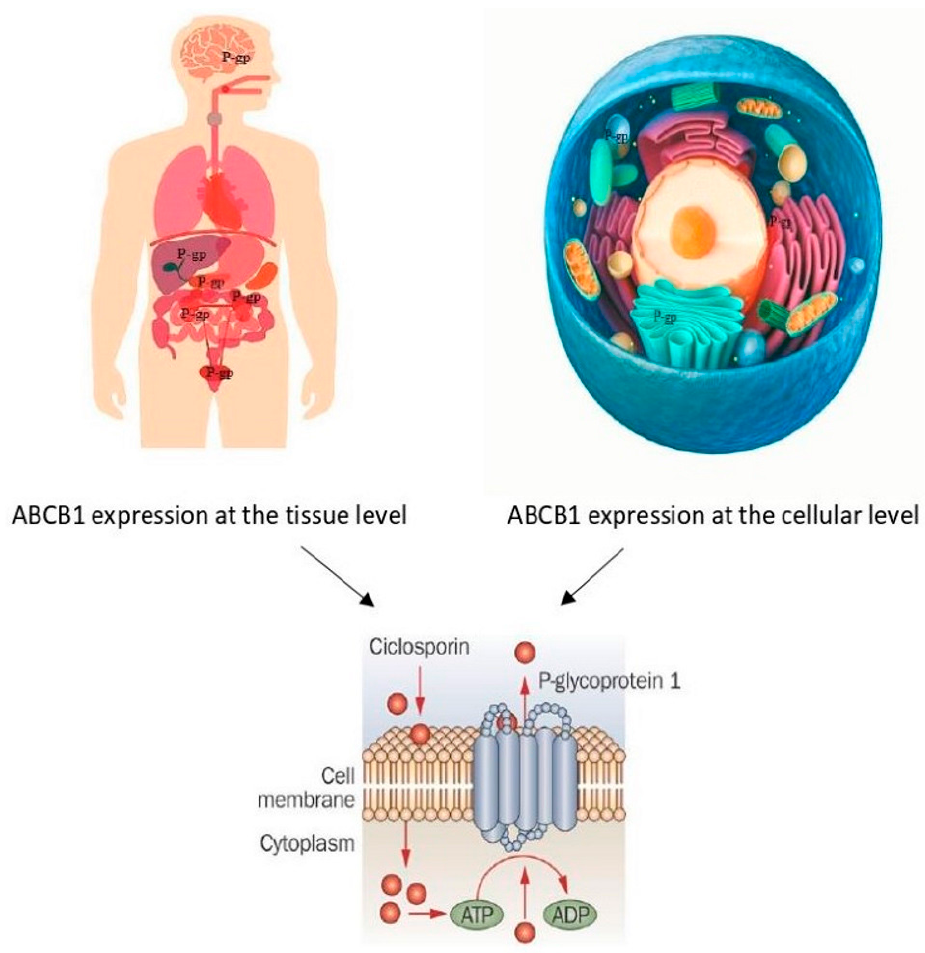
Figure 1. PGP (P-gp P-glycoprotein, ABCB1 (ATP-binding cassette sub-family B member 1), MDR1 (multidrug resistance protein 1), and CD243 expression in organs with excretory roles (e.g., liver, kidney and small intestine) and at blood–tissue barriers (e.g., blood–brain, blood–testis and blood– placenta), plasma membrane, Golgi apparatus, endoplasmic reticulum, lysosomes and endosomes and cyclosporine transport.